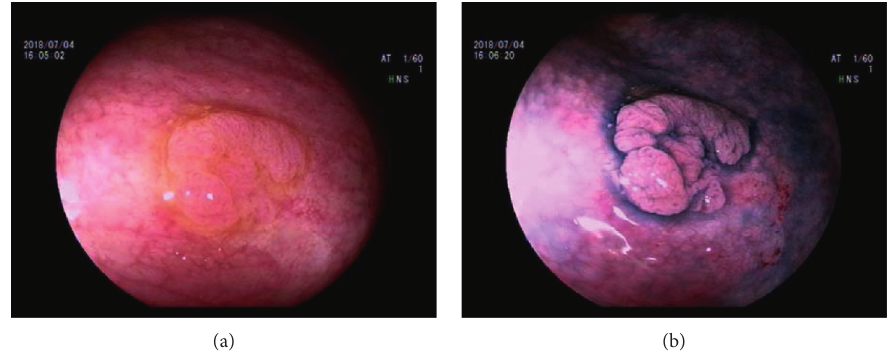
Figure 1: Flat polyp with subtle margin at the cecum ((a) white light; (b) indigo carmine).